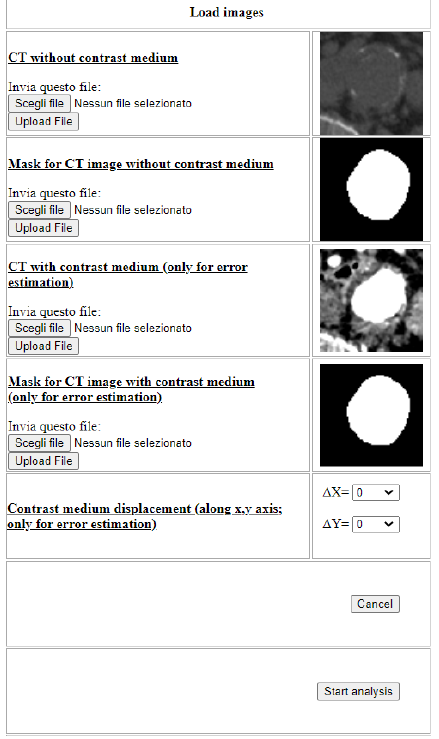
Figure 6. Interface of the web portal ImageLab.